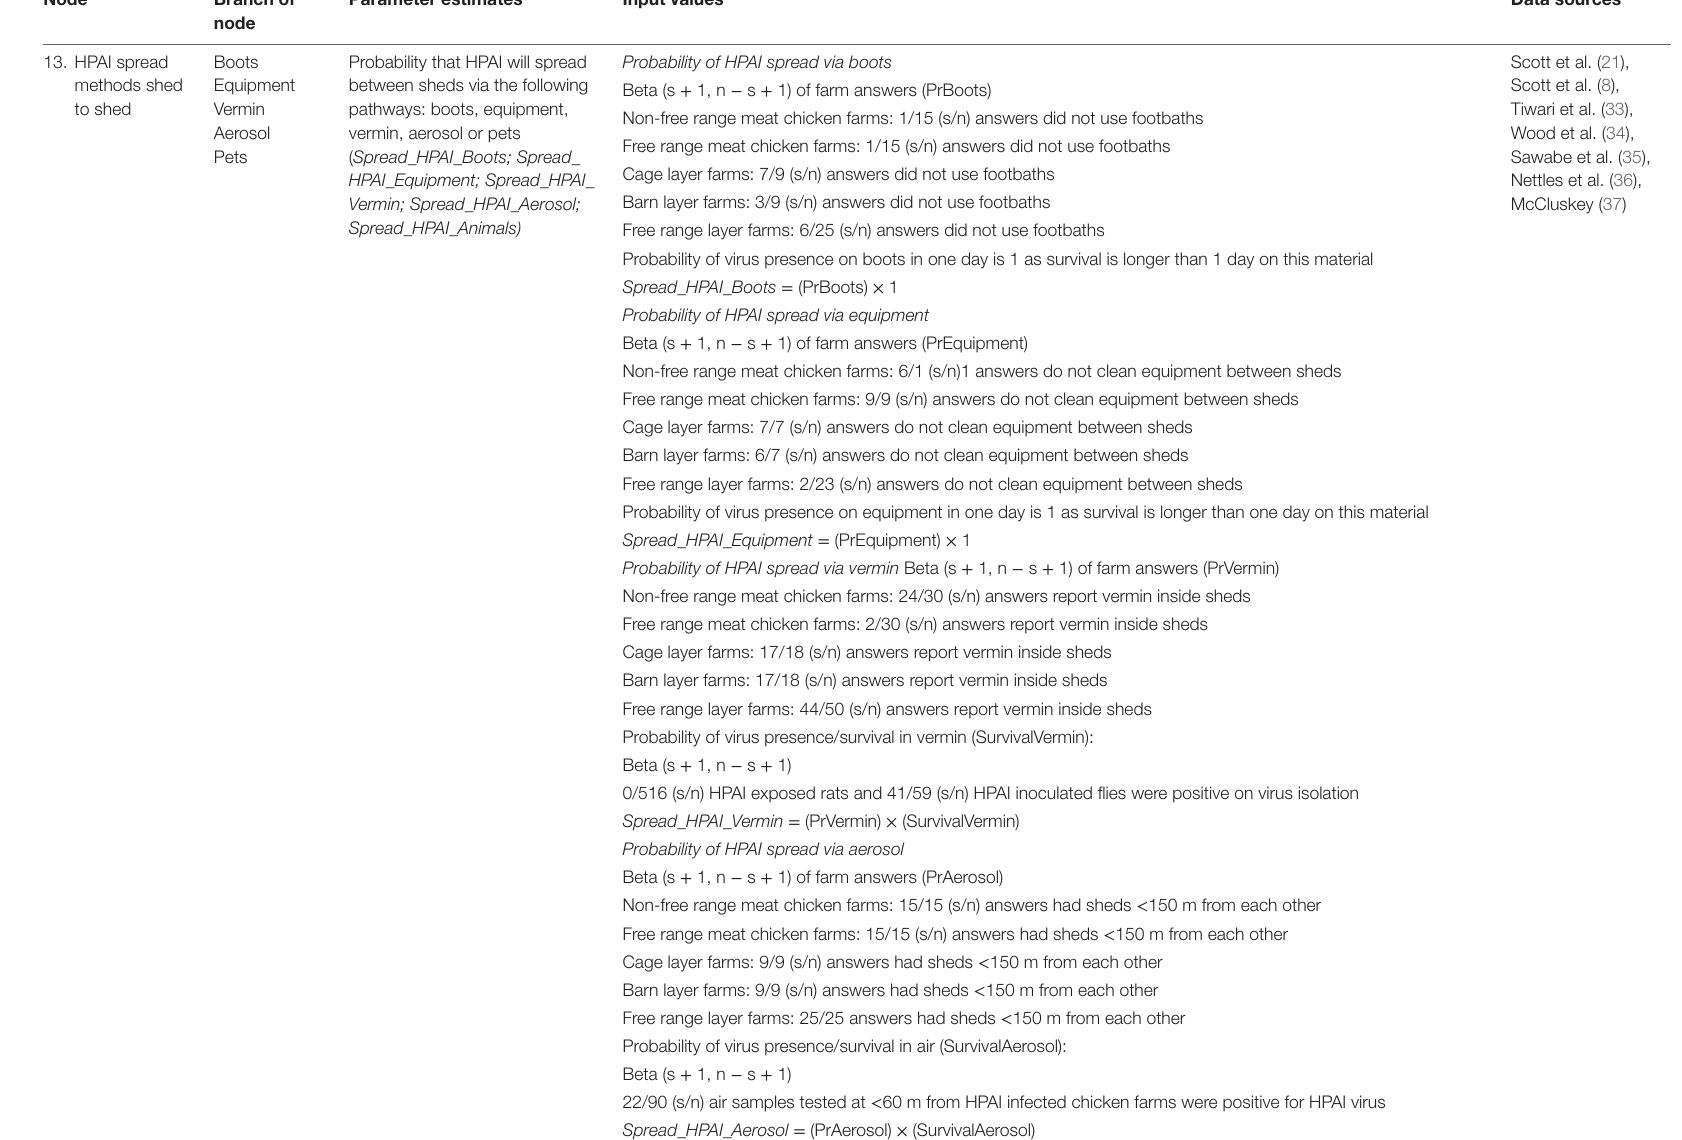
Probability of HPAI spread via aerosol Beta (s + 1, n − s + 1) of farm answers (PrAerosol) Non-free range meat chicken farms: 15/15 (s/n) answers had sheds < 150 m from each other Free range meat chicken farms: 15/15 (s/n) answers had sheds < 150 m from each other Cage layer farms: 9/9 (s/n) answers had sheds < 150 m from each other Barn layer farms: 9/9 (s/n) answers had sheds < 150 m from each other Free range layer farms: 25/25 answers had sheds < 150 m from each other Probability of virus presence/survival in air (SurvivalAerosol): Beta (s + 1, n − s + 1) Spread_HPAI_Aerosol = (PrAerosol) × (SurvivalAerosol) Probability of HPAI spread via